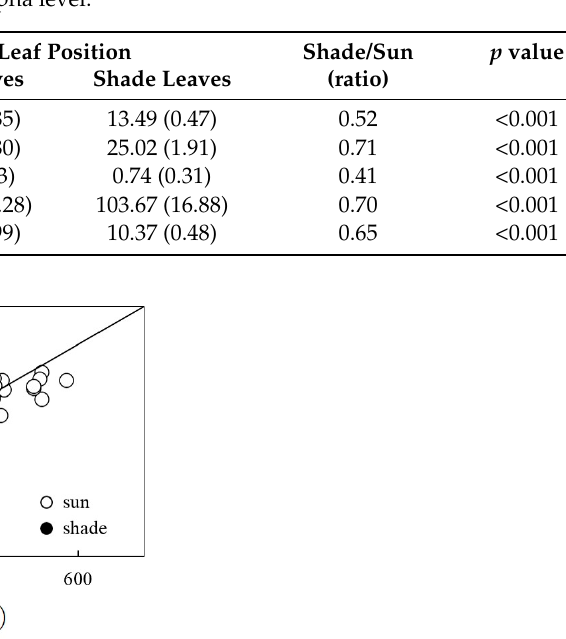
Figure 4. Relationship between maximum CO 2 assimilation rate (P max ) and maximum stomatal conductance (g s ) at saturated photosynthetic photon flux density (PPFD = 1500 µmol m − 2 s − 1 ).